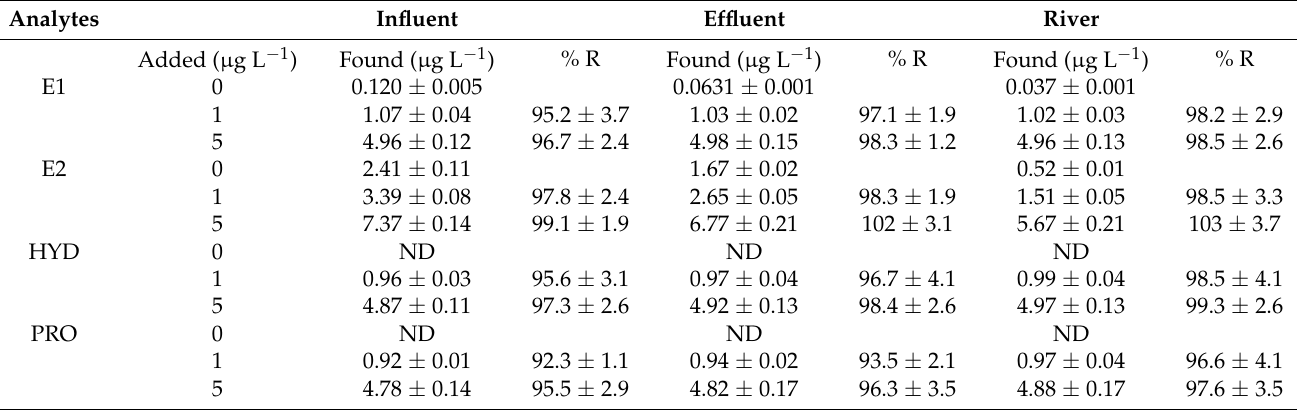
Table 4. Validation parameters of the preconcentration method in water samples ( n =